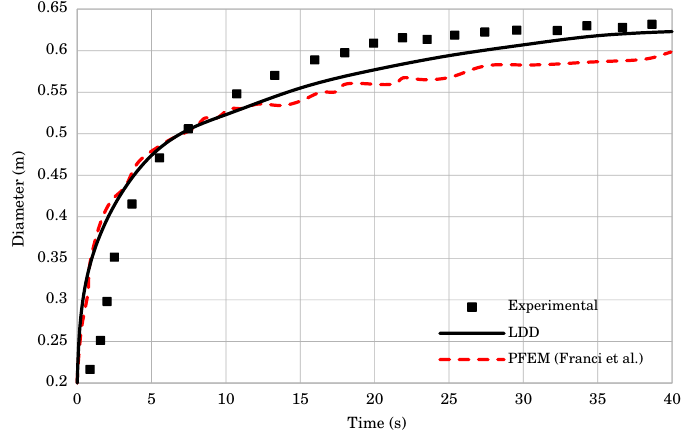
Figure 10. The evolution of the diameter for the Abram slump test. The results of the numerical simulations are compared to the experimental data.